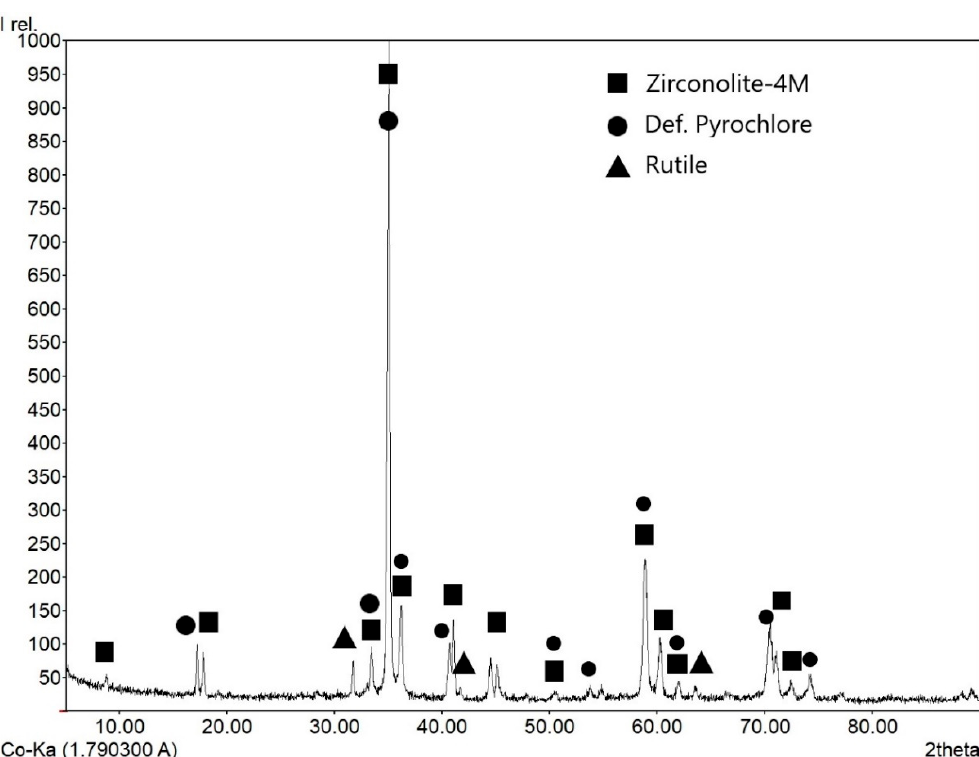
Figure A2. X-ray diffraction pattern of the sample “Nd”.